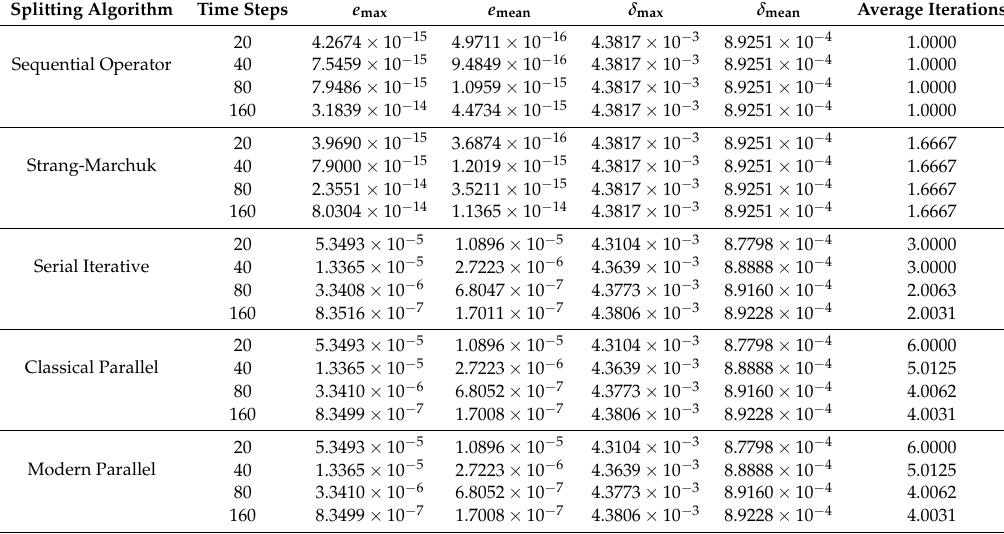
Table 7. Diffusion problem. Results of the balanced decomposition using the second order scheme for the spatial discretization, with 10 spatial subintervals and different number of temporal steps.